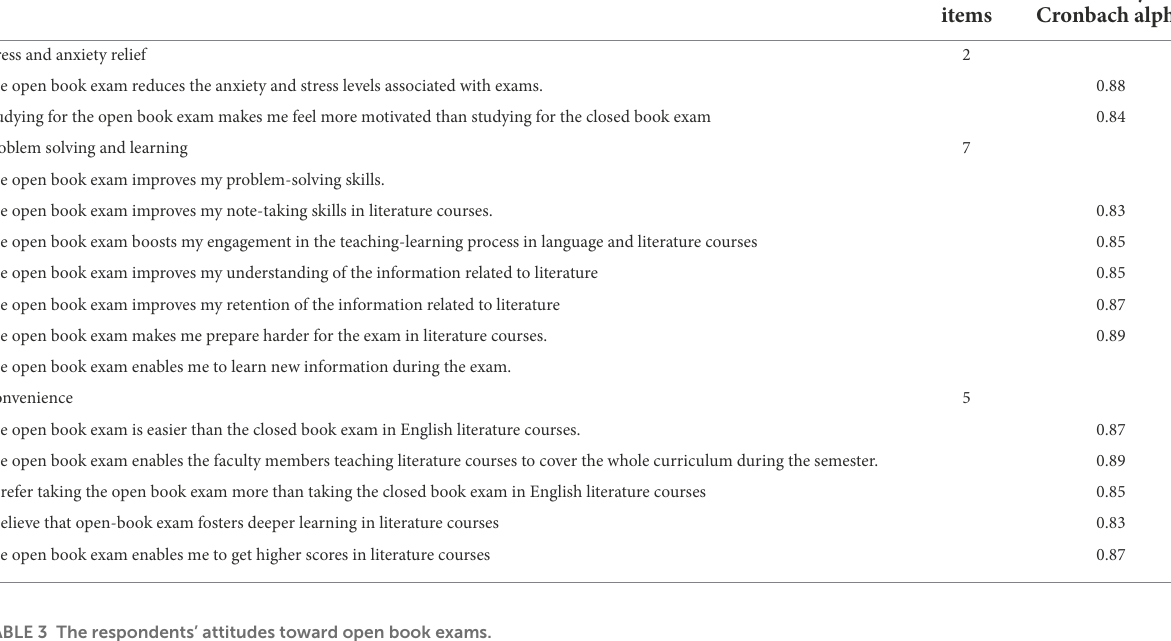
TABLE 2 Reliability test of the questionnaire. Variables Number of